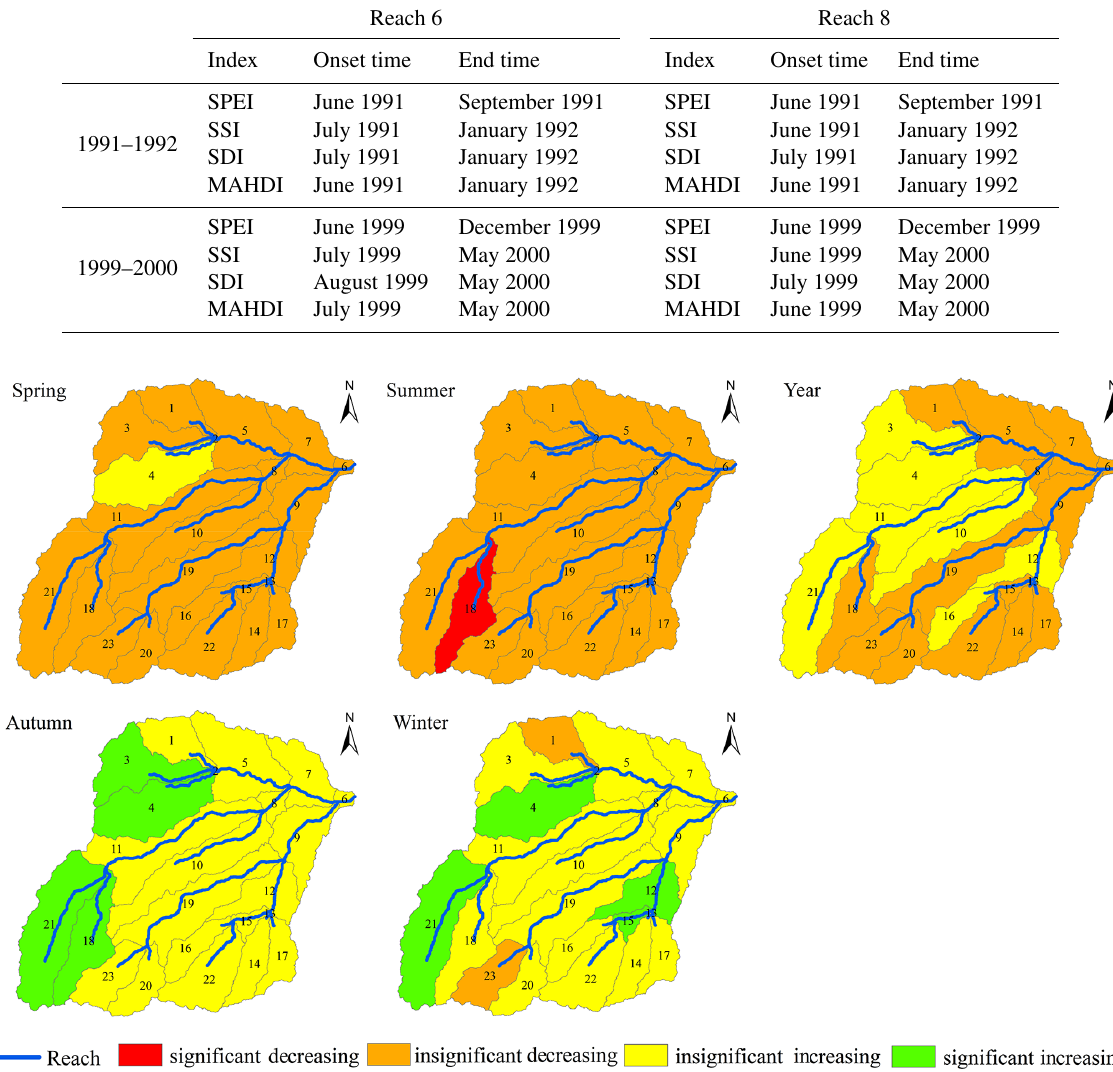
Table 3. The capture time of various drought indexes for the drought events that occurred in the periods 1991–1992 and 1999–2000 in subbasin no. 6 and subbasin no. 8.